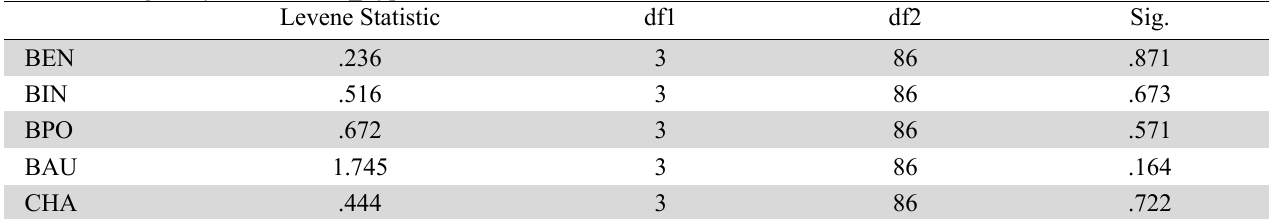
Test of Homogeneity of Variances_Types of